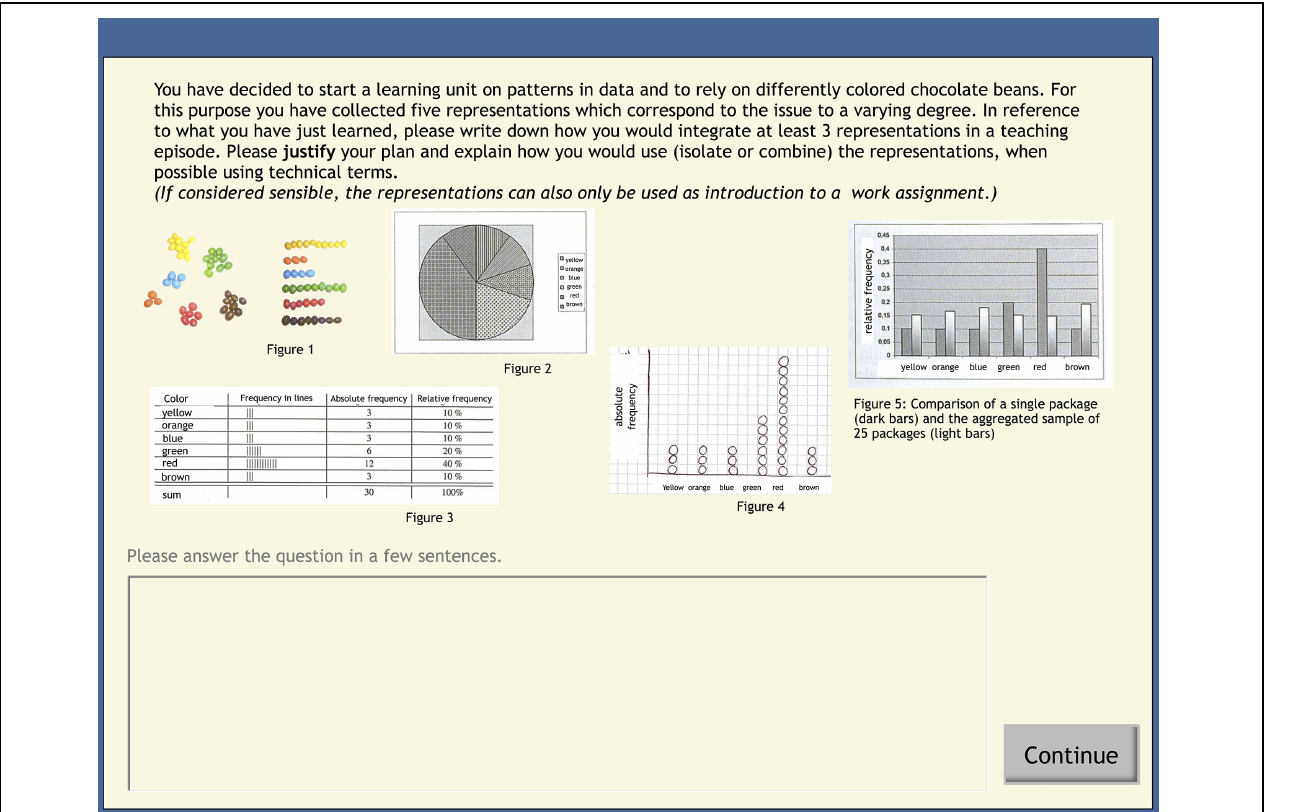
Frontiers in Psychology |